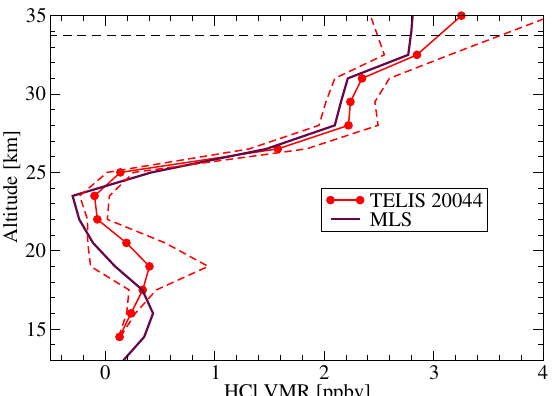
Figure 10. Comparison of HCl retrievals between TELIS and MLS on 24 January 2010. The lowest tangent height of TELIS is 16km and the retrieval results below this altitude have little physical meaning. The solar zenith angle of the MLS measurement was 84.0 ◦ . The time difference between the TELIS and MLS measurements was about